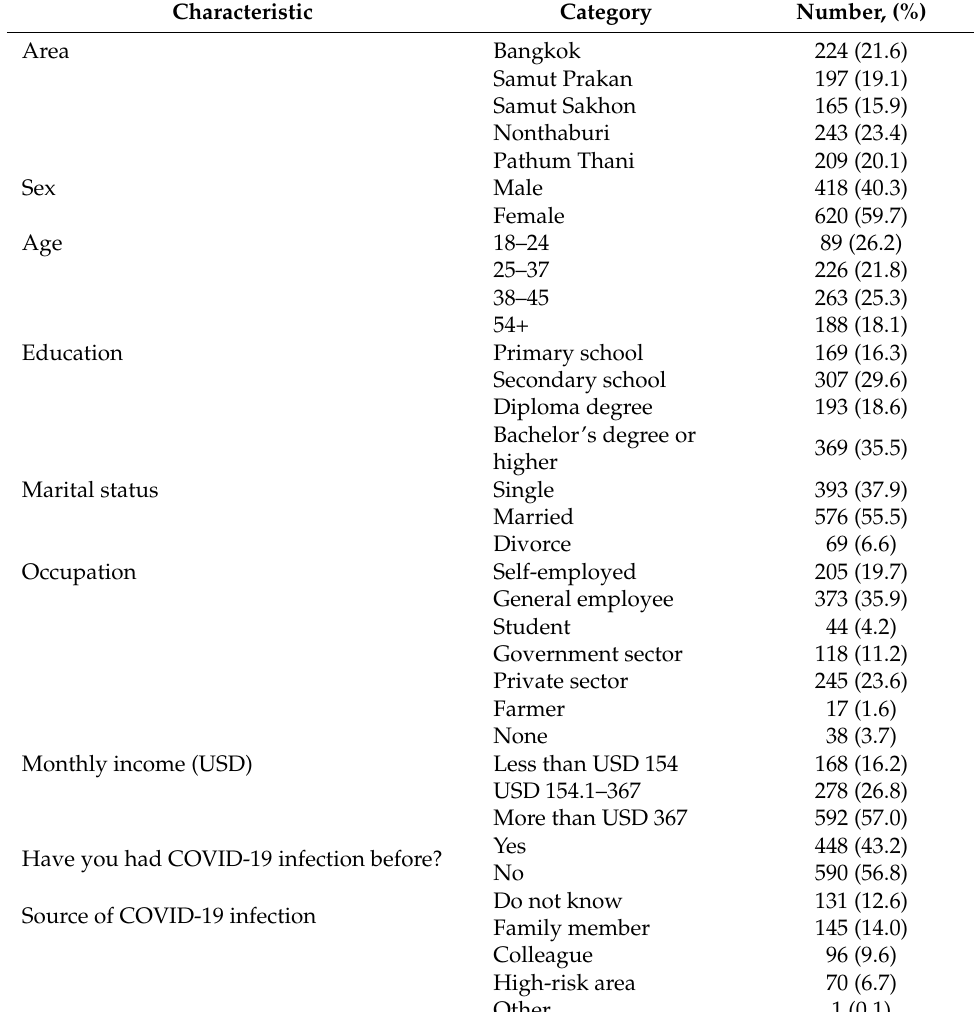
Table 3. Population characteristics ( n = 1038).